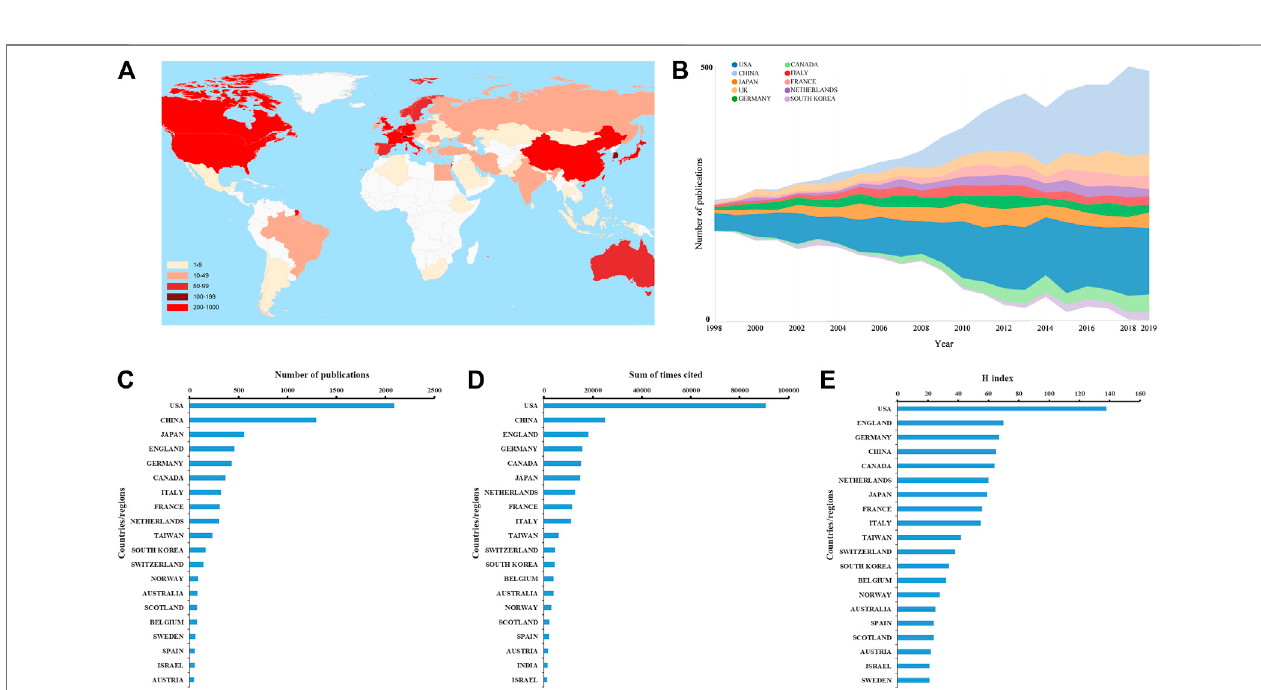
FIGURE 3 | (A) World map displaying the global distribution of ultrasound microbubble research. Different countries were denoted with different colors based on the number of articles published. (B) Growth trends in the publication quantity of the top 10 countries/regions in ultrasound microbubble research from 1998 to 2019. (C – E) Total number of publications, sum of total citations, and H-index of top 20 countries in this fi eld.